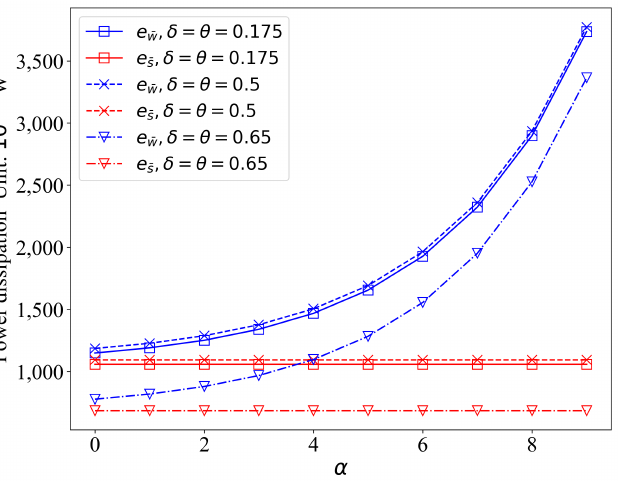
Figure 9. The power dissipation against α in base duration ¯ s and ¯ w ( d = 3.15 m, ¯ w = 1 s, ¯ s = 1